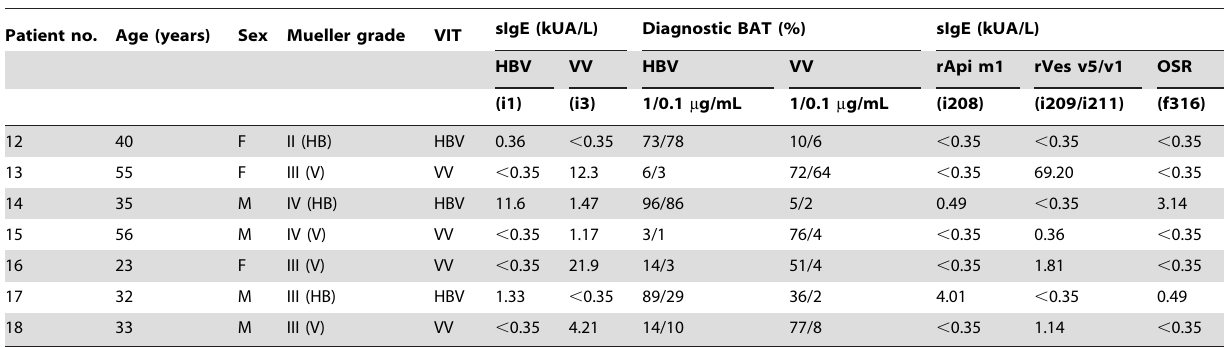
Table 2. Clinical data, sIgE and BAT in subjects for passive IgE sensitization.